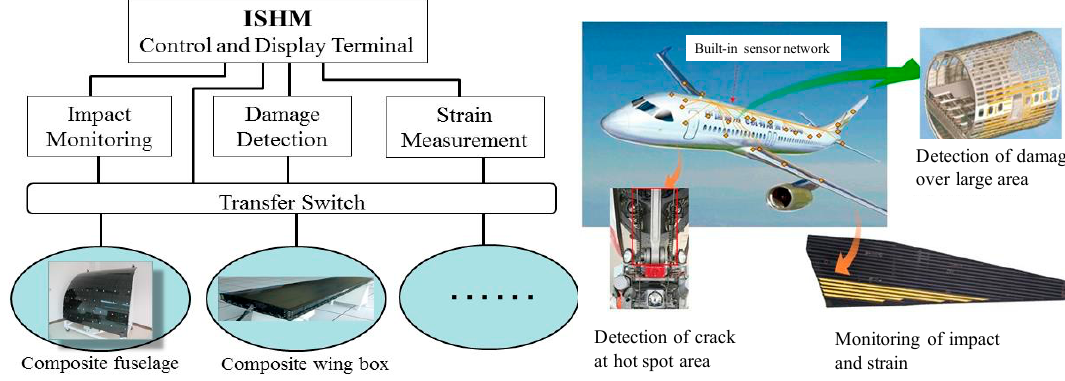
Figure 11. Architecture of integrated SHM.